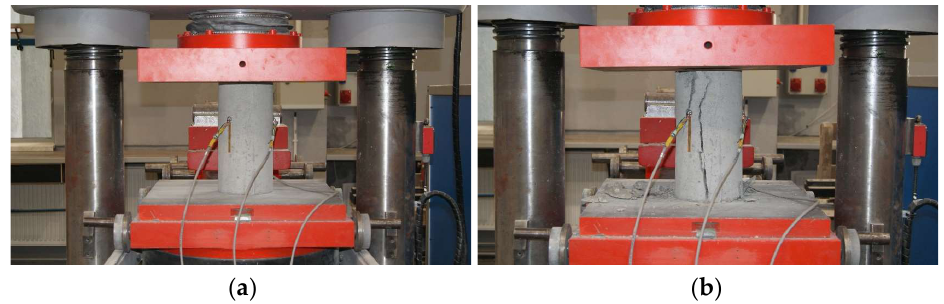
Figure 6. Concrete specimen at the time of testing: prepared for test ( a ) and after destruction ( b ).